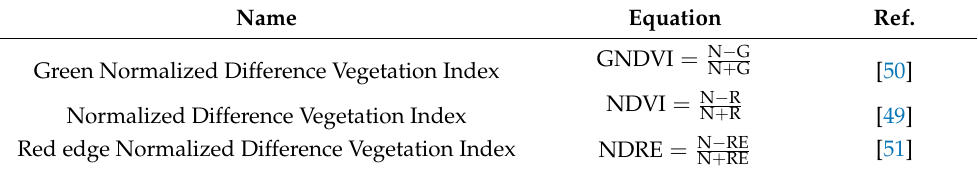
Table 3. Computed VIs found in the literature and their respective equations. G, R, RE and N are the reflectance (GER, SENOP HSC-2 and DJI P4M) and reflectivity (DJI P4M) pixel values of the green, red, red edge and near infrared bands, respectively. Name Equation